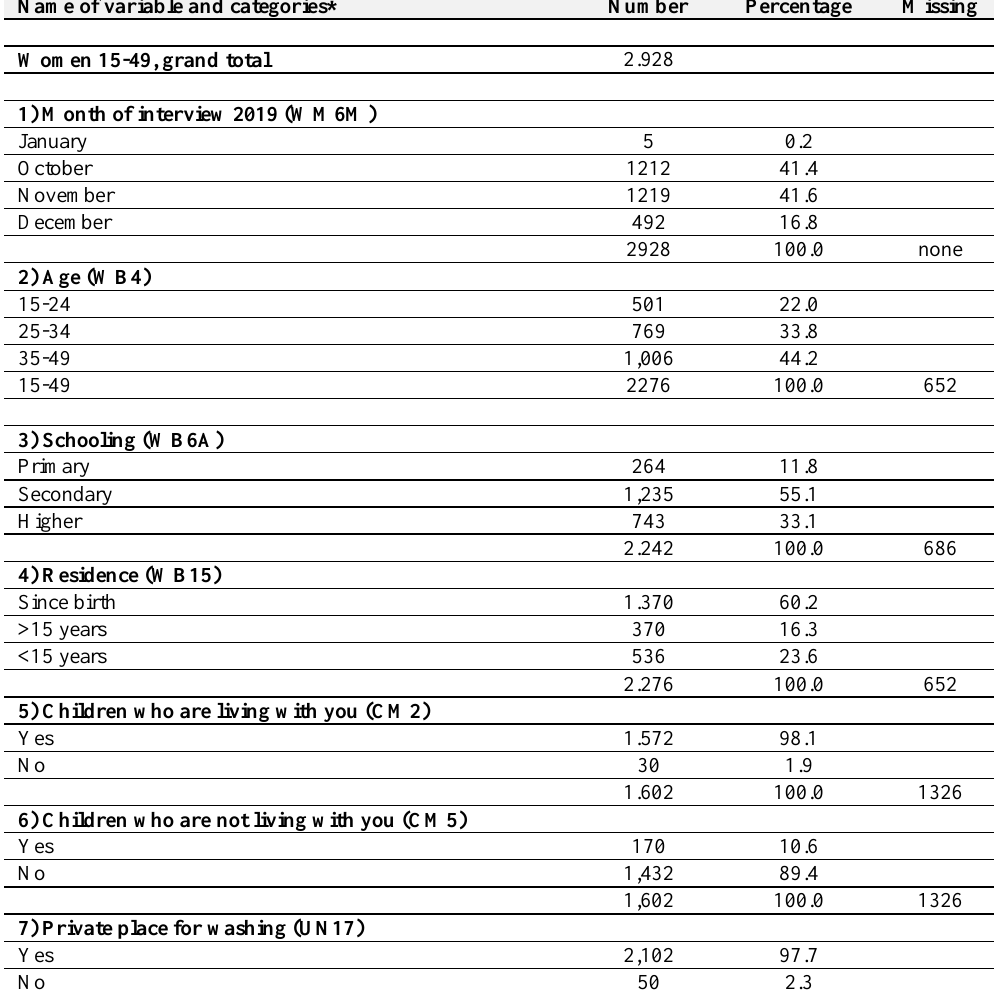
Table 2. Distribution of the variables listed in Table 1, part I